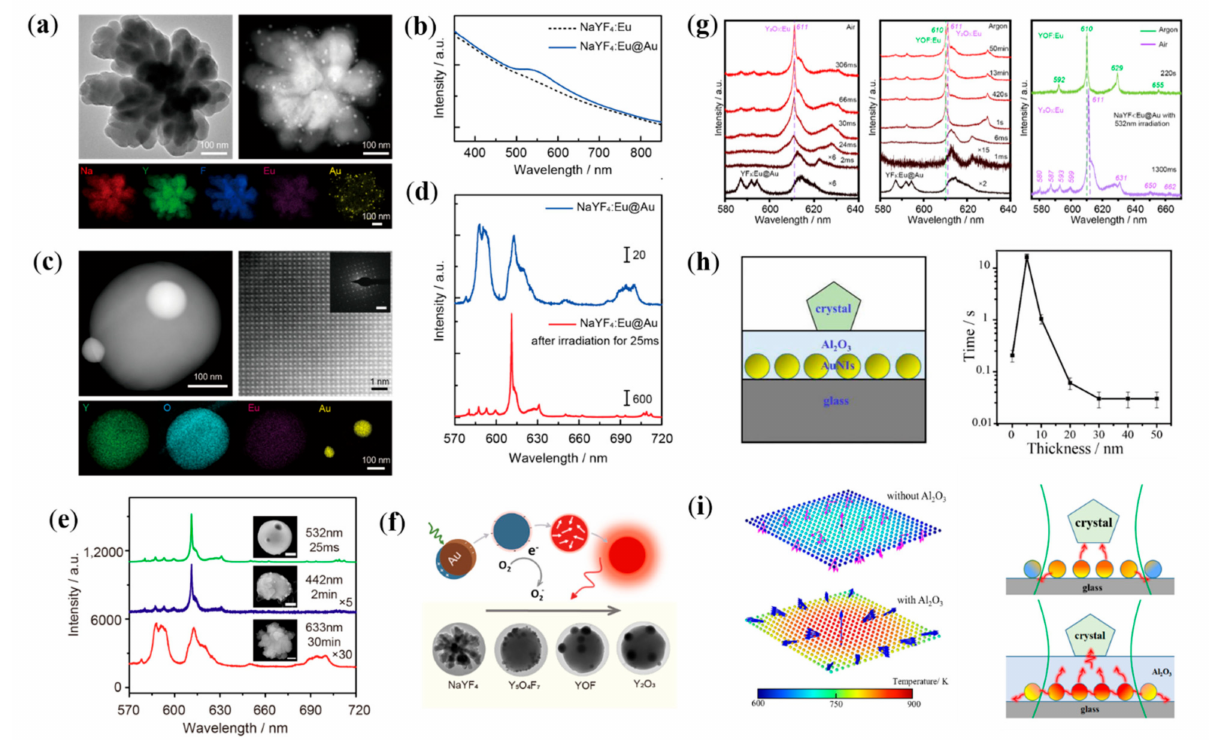
Figure 6. Plasmon-assisted crystal transformation from polycrystalline fluoride to single crystal oxide. ( a , b ) TEM, EDX maps and absorption spectra of NaYF 4 :Eu and NaYF 4 :Eu@Au; ( c ) STEM, EDX and SAED maps of transformed single-crystalline Y 2 O 3 NP; ( d ) Fluorescence spectra of NaYF 4 :Eu and NaYF 4 :Eu@Au and transformed Y 2 O 3 :Eu. ( e ) Fluorescence spectra and SEM images of transformed products after light irradiation with different wavelengths of light. ( f ) Schematic diagram of plasmon- assisted polycrystalline fluoride NPs transformation. ( g ) Evolution of luminescence spectra during the plasmon-assisted crystal (YF 3 :Eu@Au) transformation in air (left) and argon (middle), and lumi- nescence spectra of YF 3 :Eu particle after annealed at 600 ◦ C for 1 h (right) [90]. ( h ) Schematic diagram of heat trapping structure (left) and the required irradiation time for the crystal transformation with different thickness of dielectric layer Al 2 O 3 (right). ( i ) Simulated thermal transfer modes (left) and schematic diagram of the mechanism (right) of pure Au nanoislands and Au nanoislands/Al 2 O 3 systems, the direction of the arrow representing the direction of heat flow